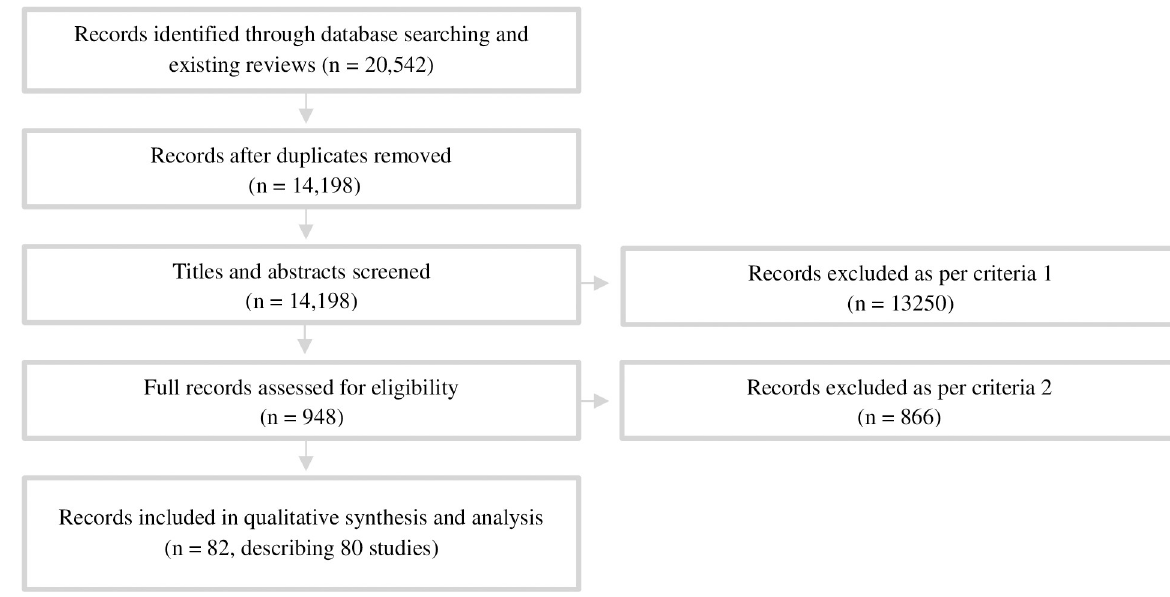
Fig 1. Inclusion and exclusion flowchart for systematic review [17]. Criteria 1: Primarily about menstruation or sexual and reproductive health; Criteria 2: Published post-1999 and discusses behaviours post-1999, in English or has an English translation available, discusses menstrual material disposal, washing, drying and/or reuse and gives reasons for these